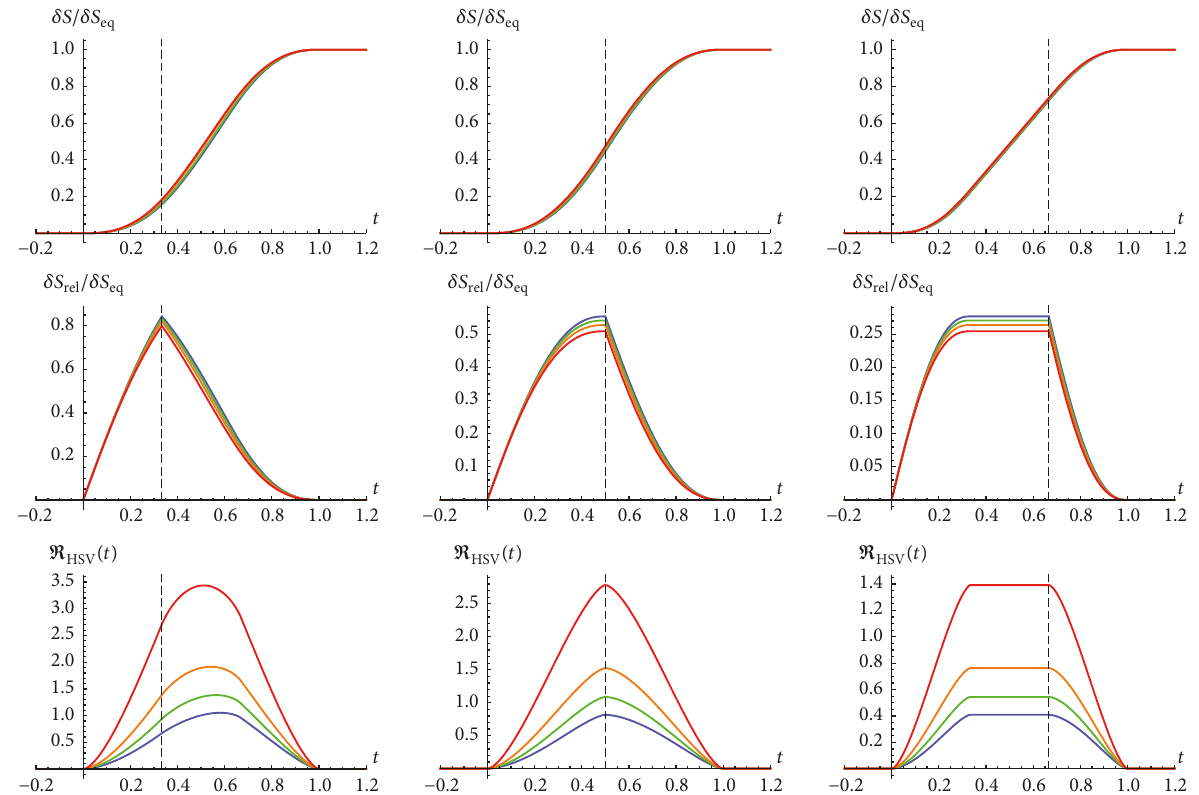
Figure 10: Entanglement entropy, relative entropy, and entanglement velocity for different values of 𝜃 . Colors blue, green, orange, and red represent 𝜃 = {0.1,0.7,1.2, 1.7} , respectively. Plots from left to right have 𝑡 𝑞 /𝑡 ∗ = {0.5,1, 2} . In all plots, the dashed vertical line denotes the end of the driven phase 𝑡 = 𝑡 𝑞 . We have set 𝑑 = 3 , 𝑝 = 1 , and 𝑧 = 1.5 .